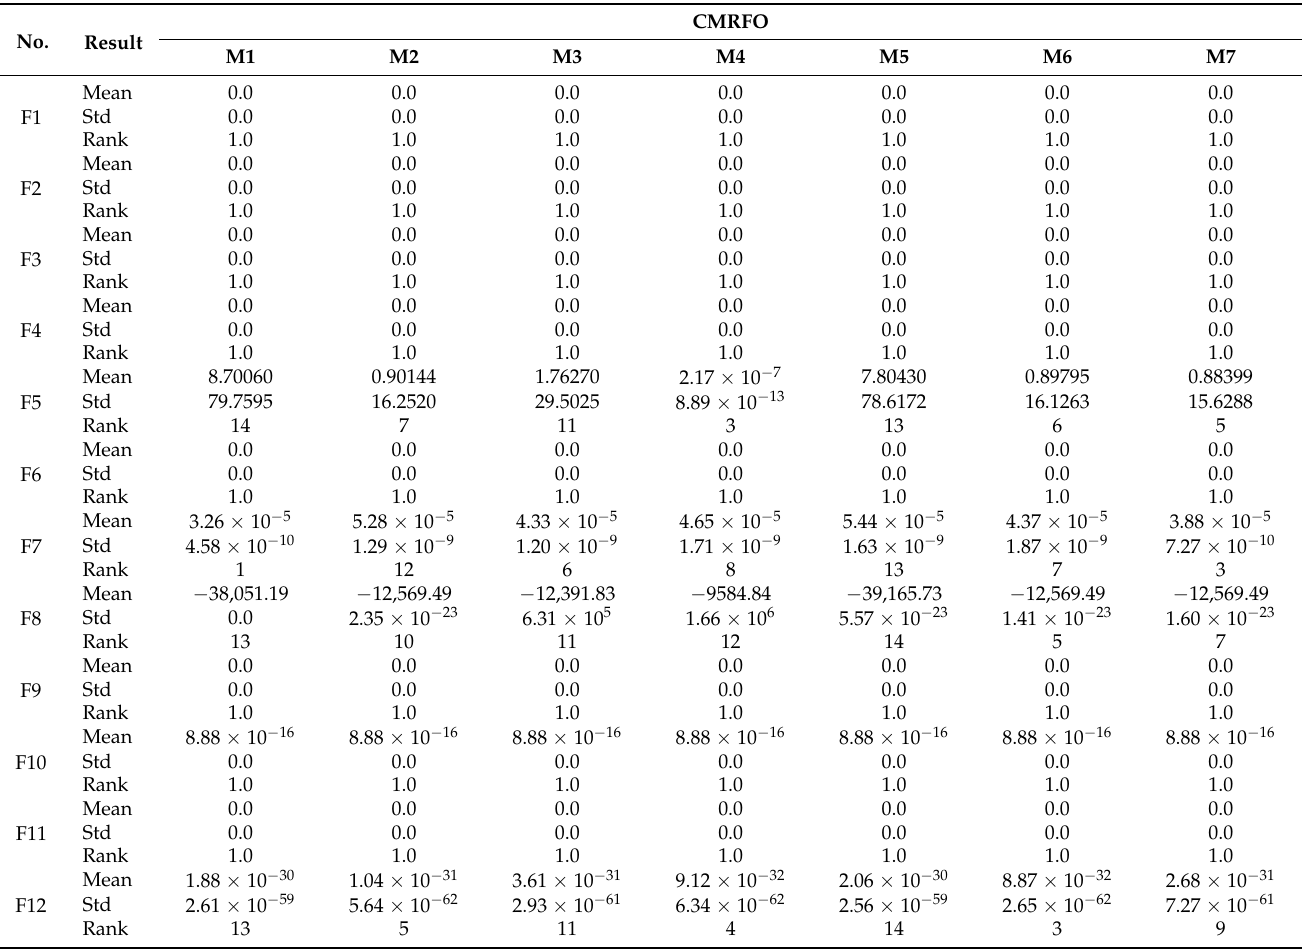
Table 2. Results of the CMRFO using 14 different chaotic maps on 23 benchmark